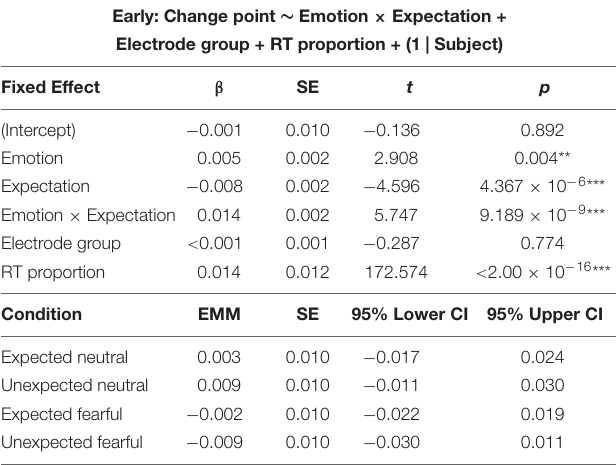
TABLE 3 | Change point models for Experiment 2.